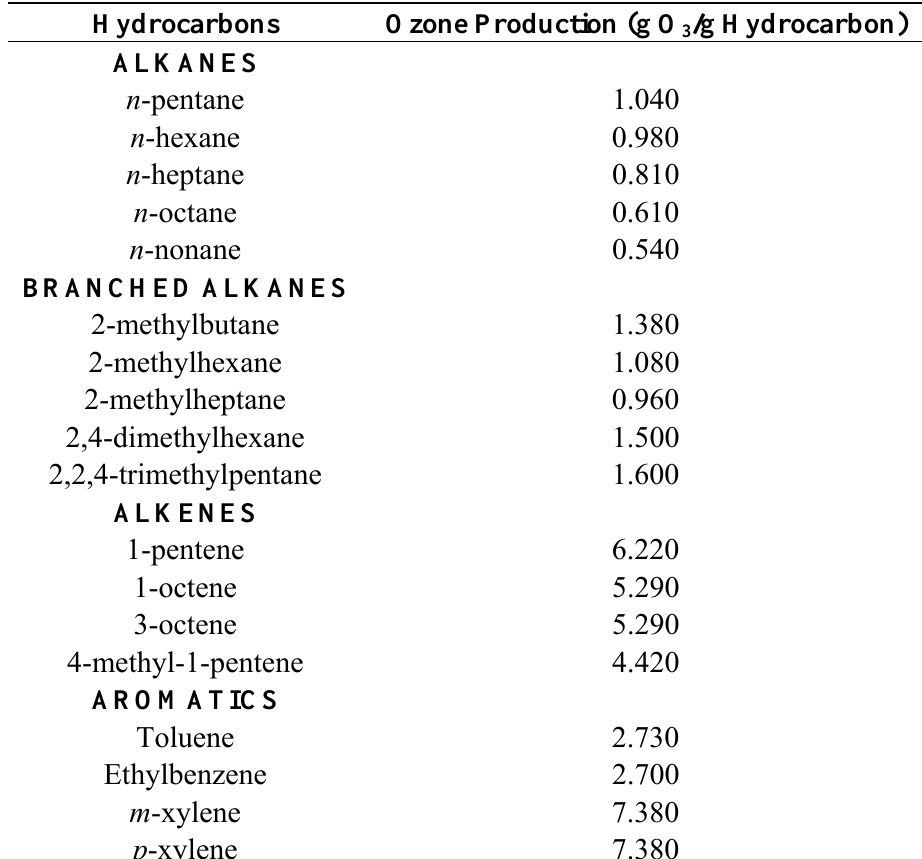
Table 1. Photochemical reactivity for pure